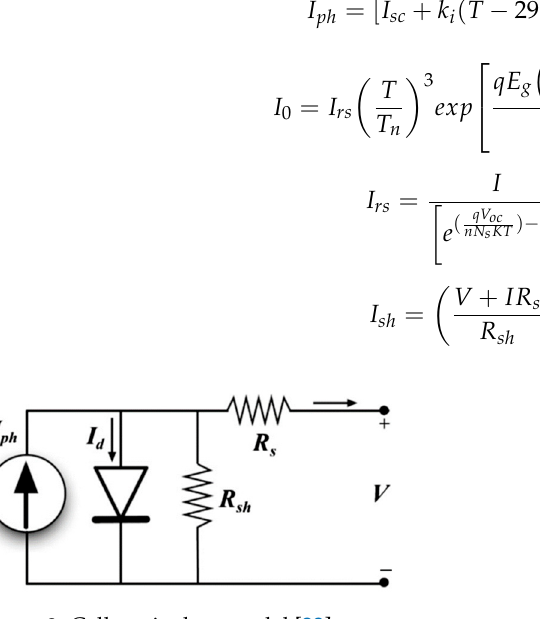
Figure 3. Cell equivalent model [22].